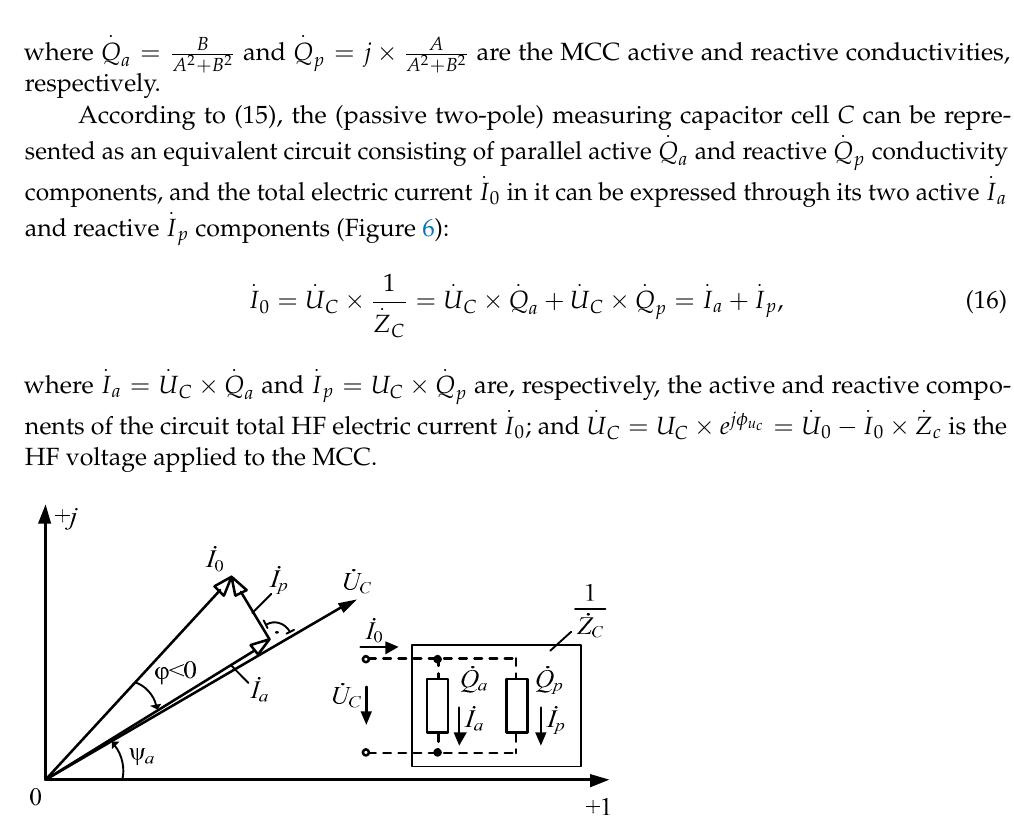
Figure 6. Vectogram of HF voltages and currents.